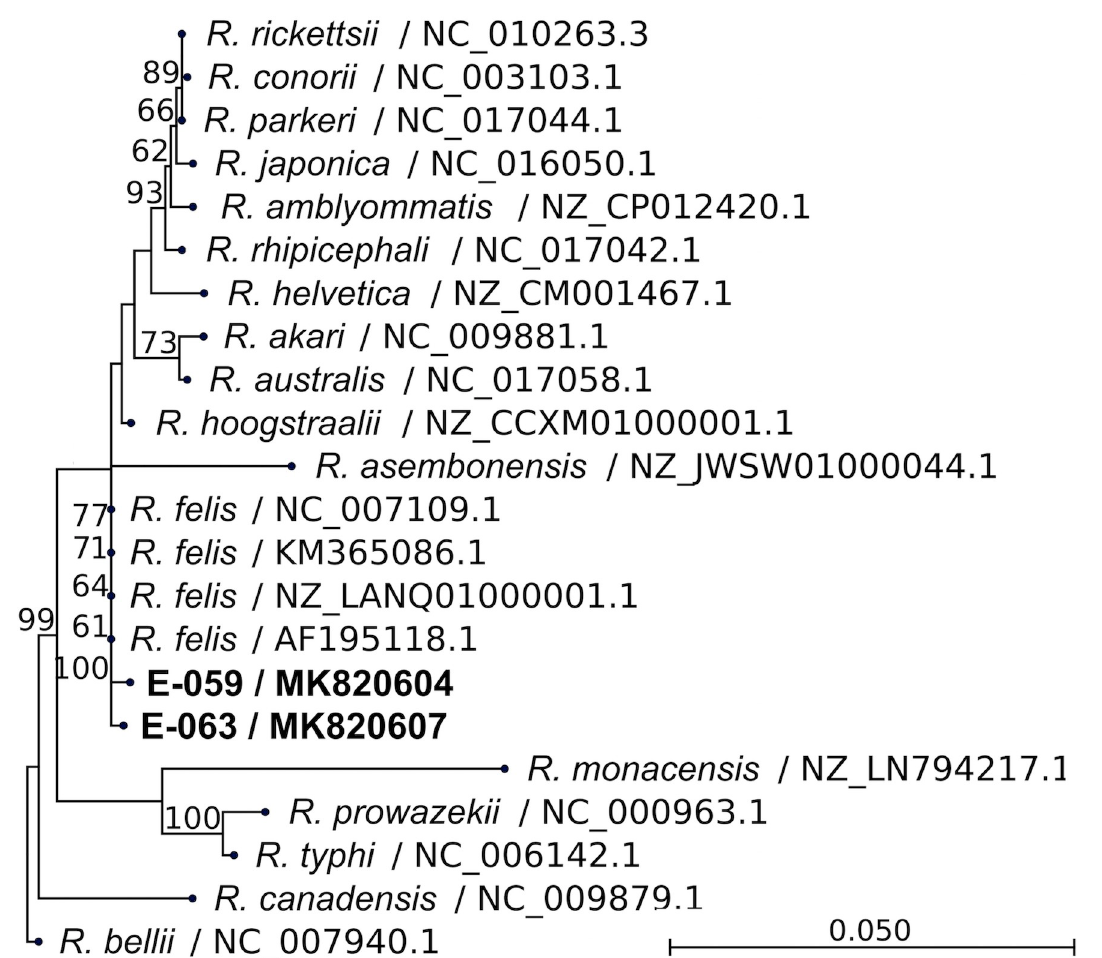
Fig 1. Phylogenetic tree comparing 17-kDa gene fragment of Rickettsia from patients to other Rickettsia species. Gene fragment size was 381 bp. Bootstrap percentages ( � 60%) are shown on internal branches. Label indicates Rickettsia species / accession number. The scale bar represents the number of nucleotide substitution per